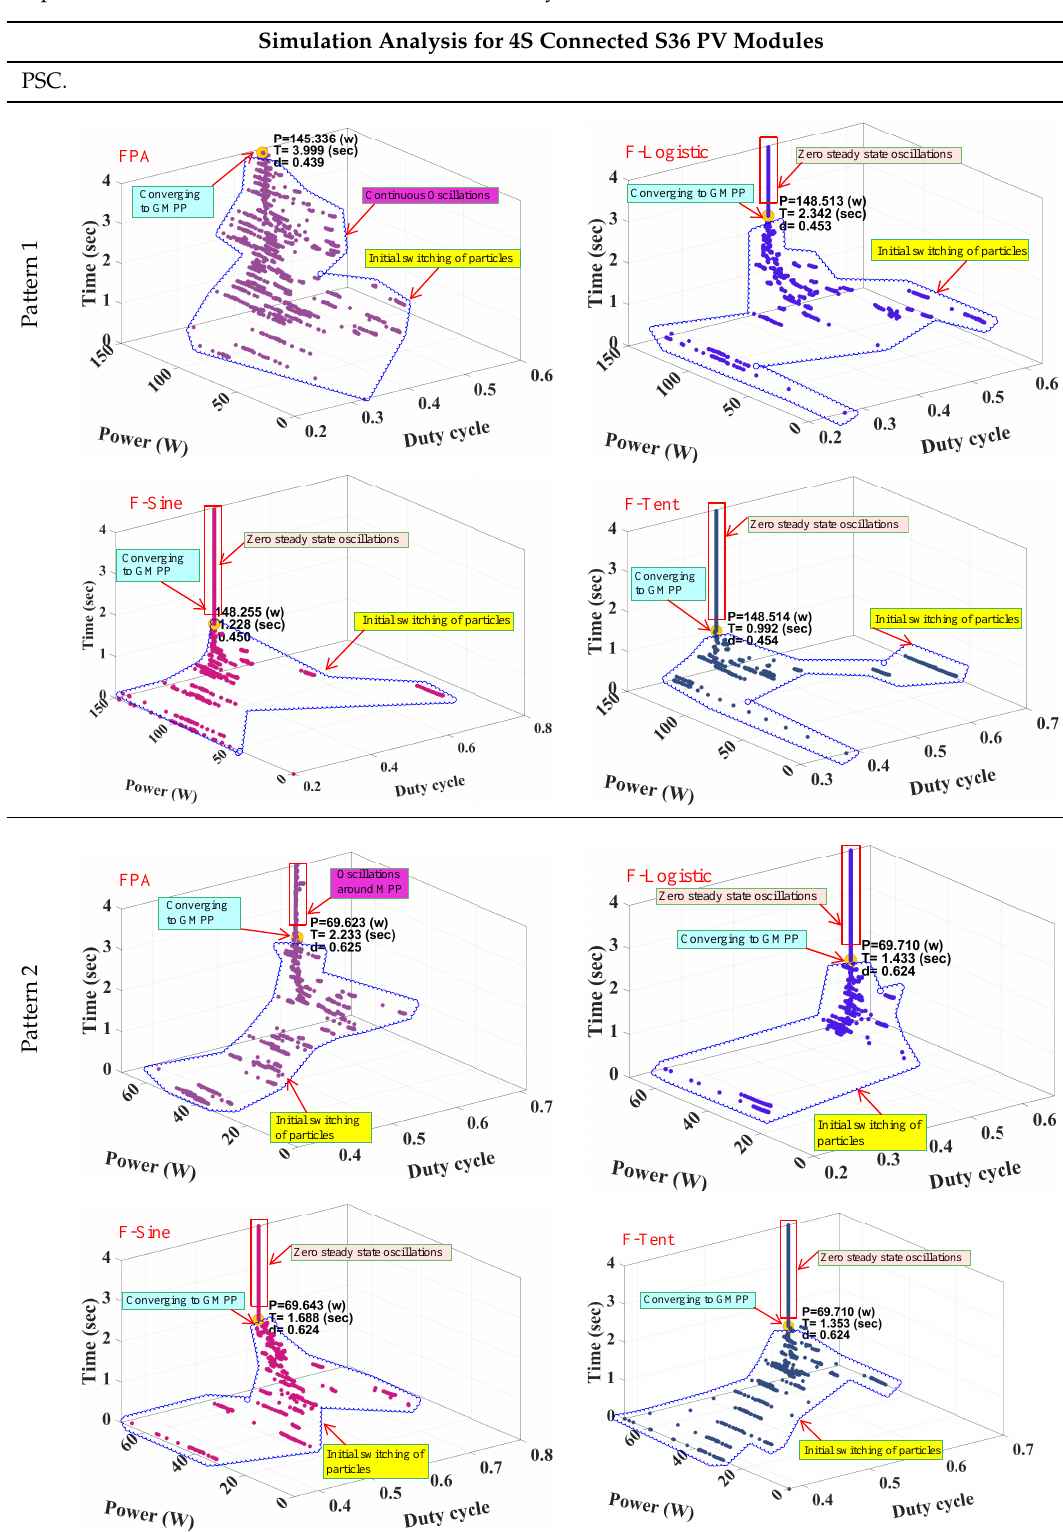
Table 4. Simulated mean power, and duty cycle of FPA and FC-FPA variants over number of runs for patterns 1, 2, and 3 of the 4S connected S36 PV